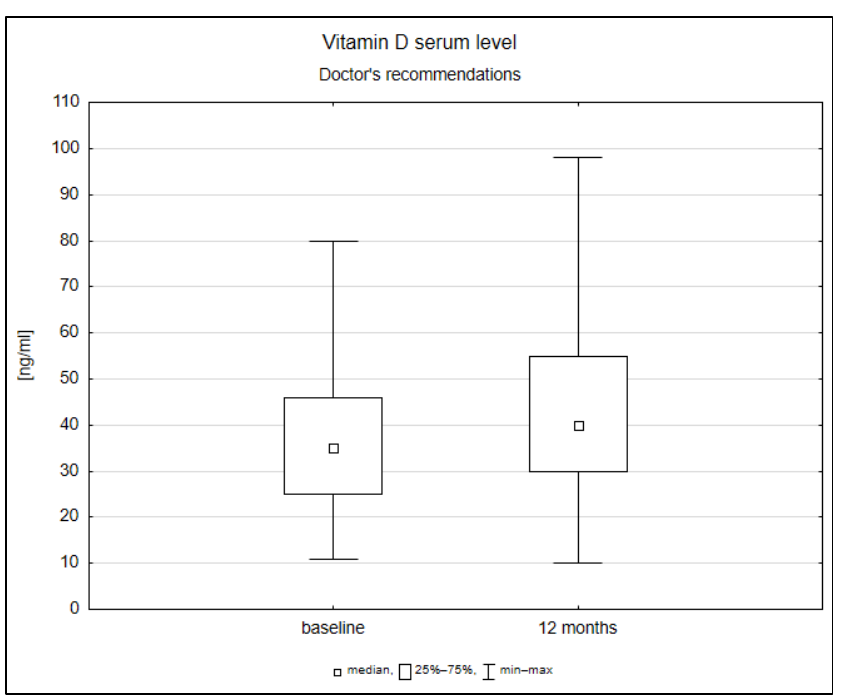
Figure 1. Box blot of change in vitamin D serum levels after 12 months of observation in patients with a doctor’s recommendation for vitamin D supplementation.